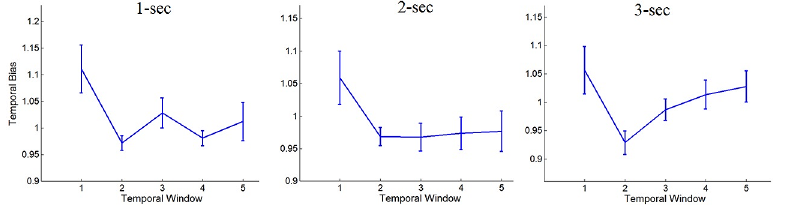
Fig 4. Temporal-integration profiles in Exp. 1, for the different trial durations (1, 2 and 3 seconds). Y- axis shows the relative influence of the signal-perturbation on accuracy, as compared to baseline (see text); X-axis depicts the 5 temporal-windows each corresponds to 1/5 of a trial); error bars denote 1 within- participant S.E.M [39].